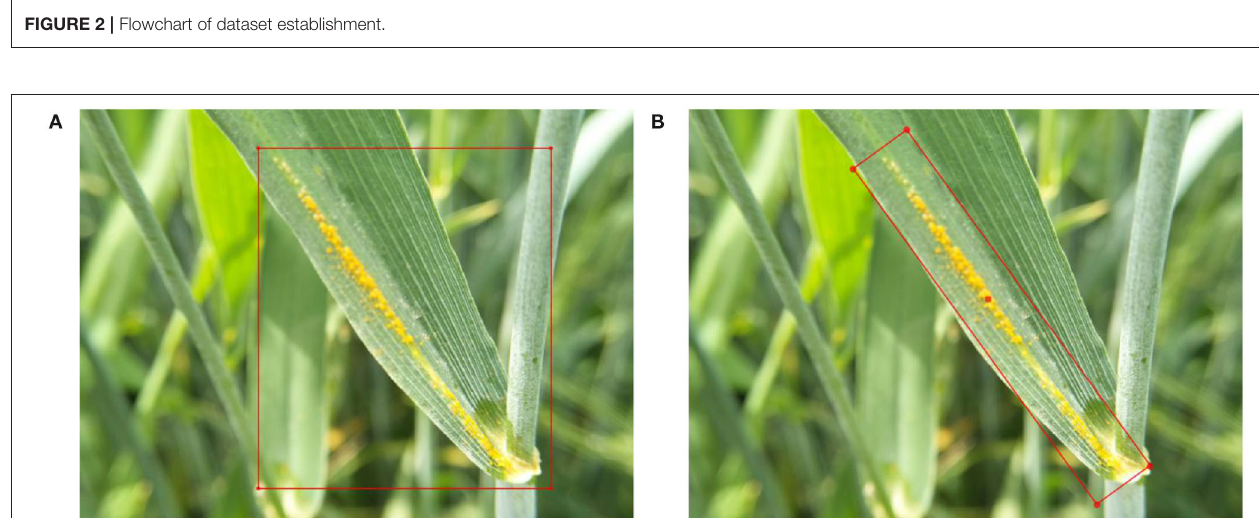
FIGURE 2 | Flowchart of dataset establishment.